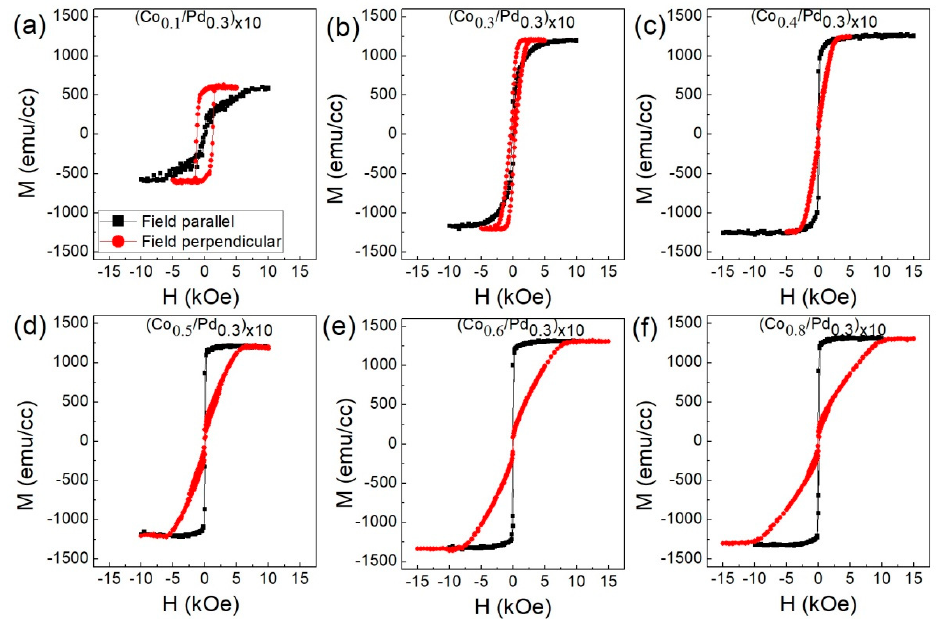
Figure 2. In-plane (black square) and out-of-plane (red circle) magnetic hysteresis loops for the sample ( a ) (Co 0.1 /Pd 0.3 ) × 10 , ( b ) (Co 0.3 /Pd 0.3 ) × 10 , ( c ) (Co 0.4 /Pd 0.3 ) × 10 , ( d ) (Co 0.5 /Pd 0.3 ) × 10 , ( e ) (Co 0.6 /Pd 0.3 ) × 10 , ( f ) (Co 0.8 /Pd 0.3 ) × 10 of series 1.